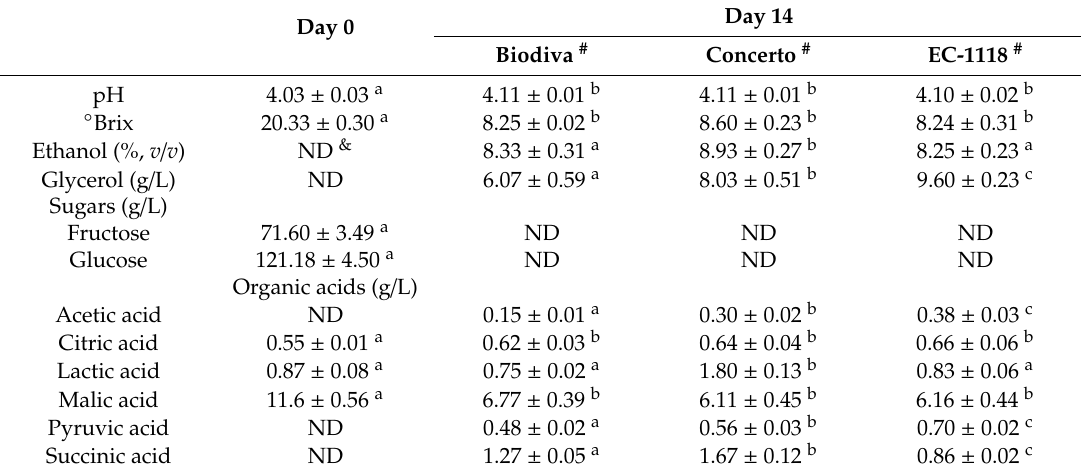
Table 1. Oenological parameters of red dragon fruit musts fermented with Saccharomyces and non- Saccharomyces yeast